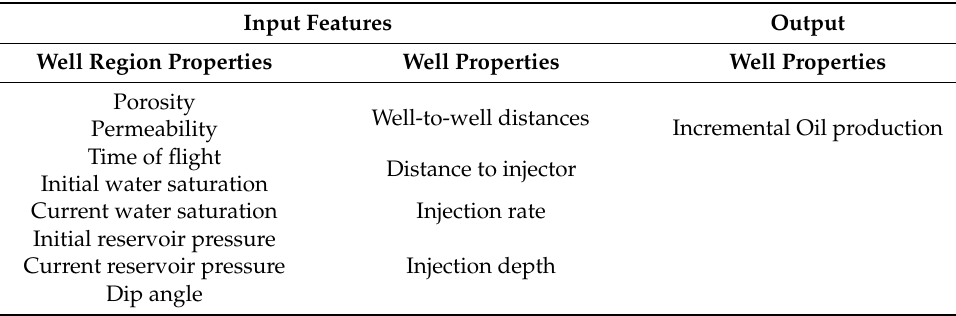
Table 6. Key input and output features for the waterflood